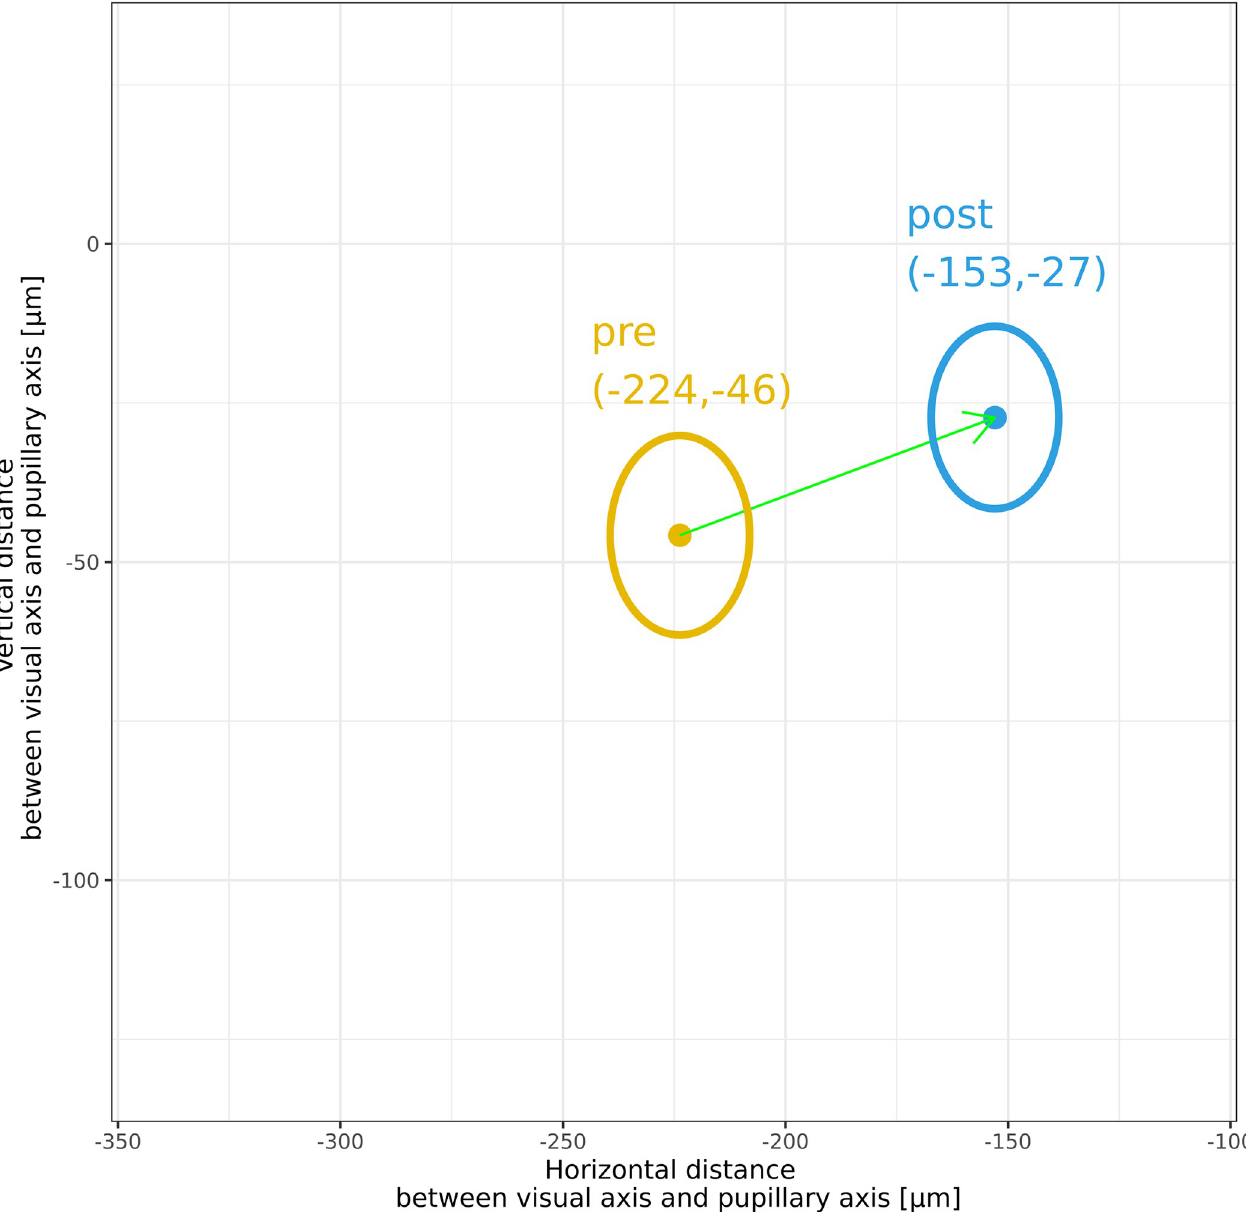
Fig 3. Change of angle kappa magnitudes: Difference vector in terms of preoperative and postoperative visual axis (overall group). pre: preoperative, post: postoperative.